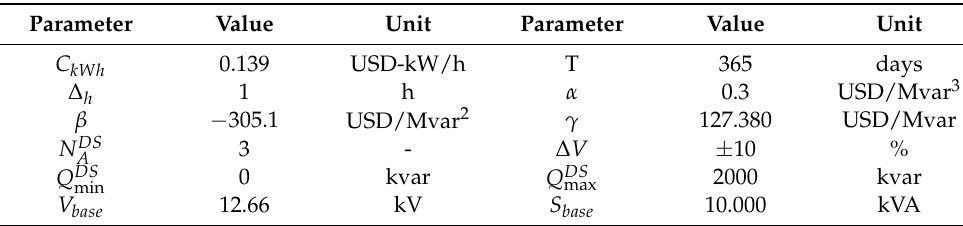
Table 4. Data on the D-STATCOM parameters for calculating the investment